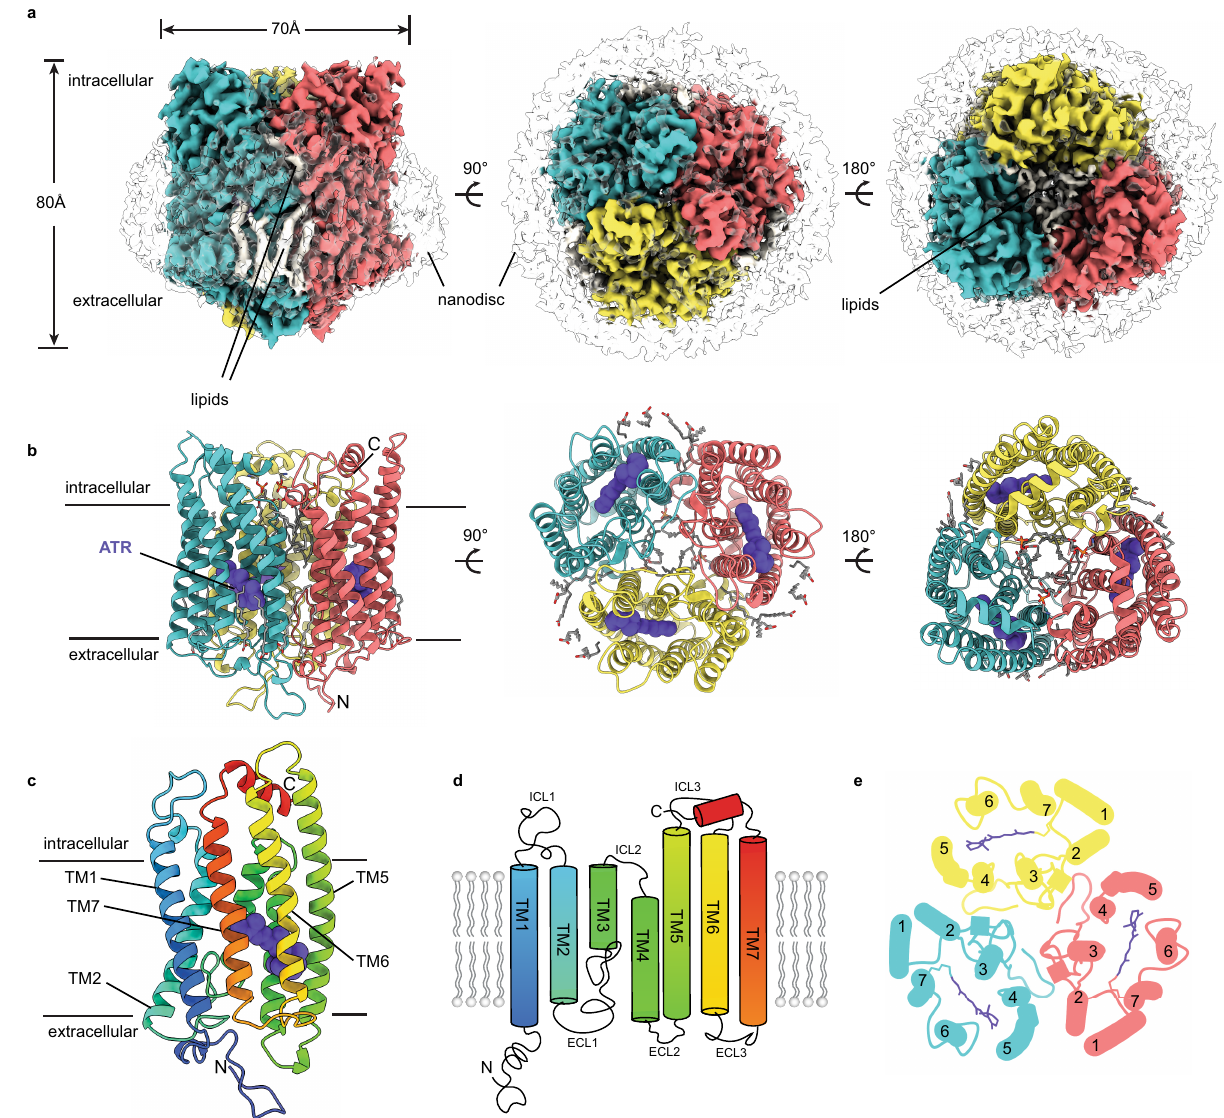
Fig. 1 | Structure ofChRmine in lipid nanodiscs.a Cryo-EM map of retinal-bound ChRmine in a MSP1E3D1 nanodisc at 2.7Å resolution viewed from (left) the mem- brane plane, (middle) the extracellular side, and (right) the intracellular side. Sub- unitsarecoloredred,teal,oryellow;lipidsarewhite;andthenanodiscistransparent.